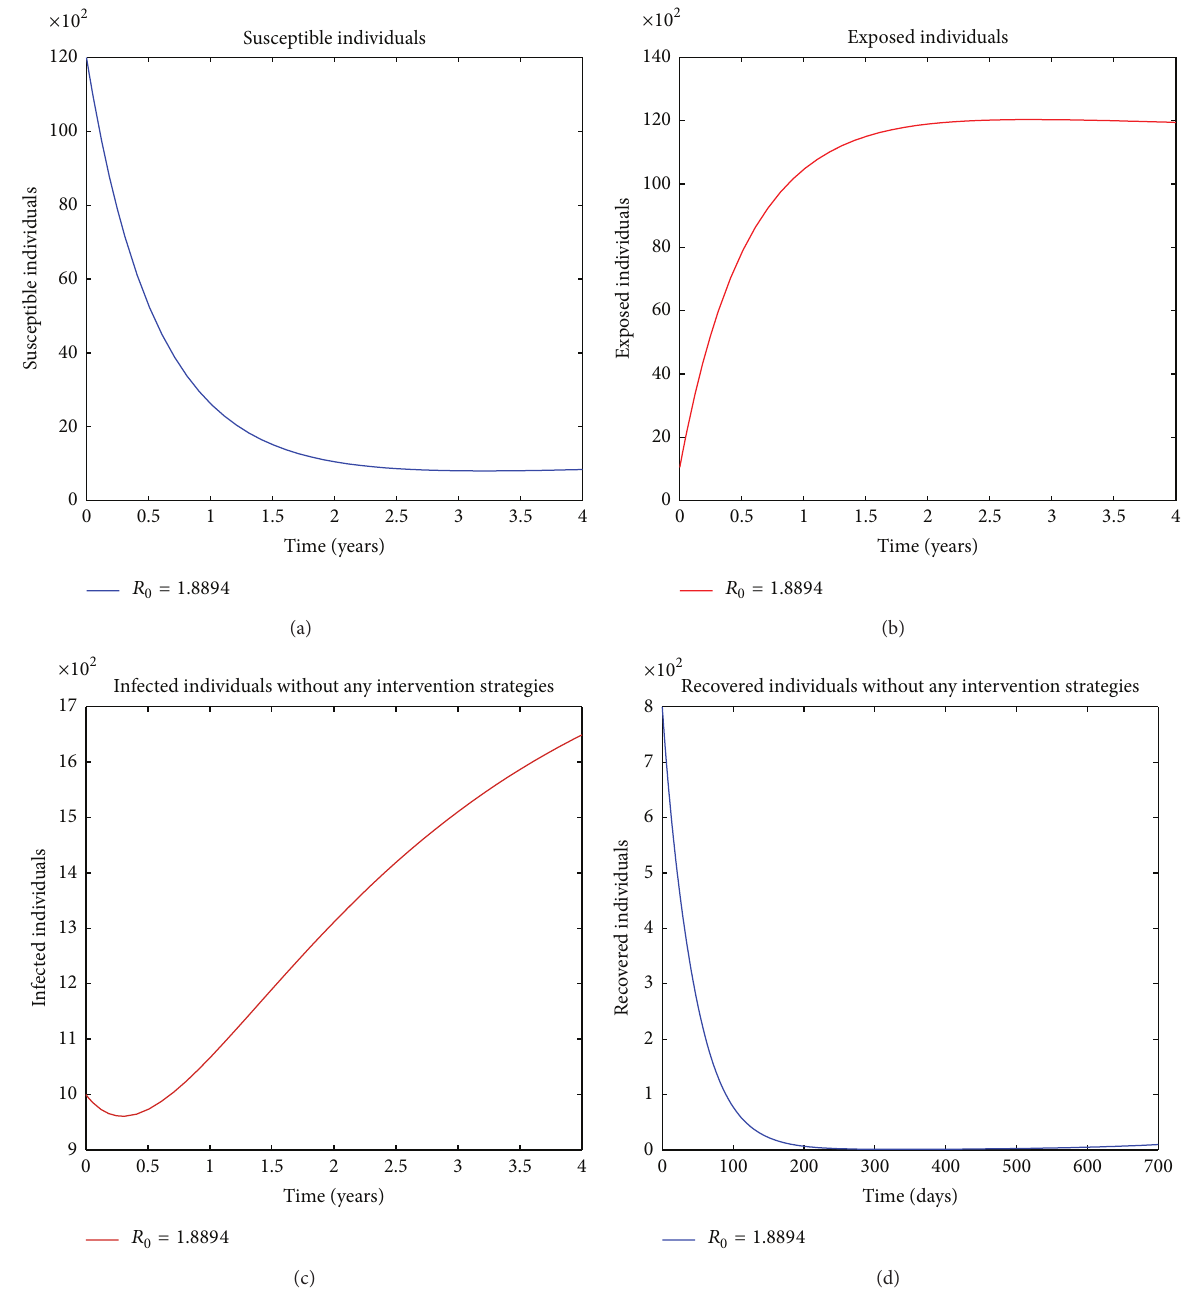
Figure 5: The changes in the four state variables of the malaria model without intervention strategies illustrating the dynamics, with time, of (a) susceptible individuals, (b) exposed individuals, (c) infected individuals, and (d) recovered human